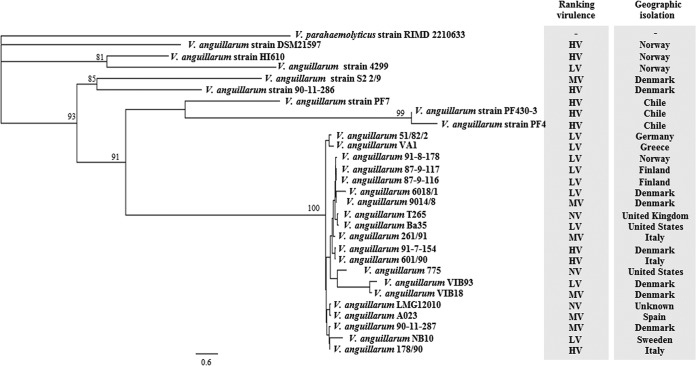
Core genome phylogeny of V. anguillarum strains. The maximum likelihood tree was obtained from a concatenated nucleotide sequence alignment of the orthologous core genes (1,723 genes for both chromosomes) for the 28 V. anguillarum strains. The virulence properties of the strains and geographical places of isolation were added to improve comparison. Bootstrap values of <80% were removed from the tree. The horizontal bar at the base of the figure represents 0.6 substitution per nucleotide site. The virulence ranking of the strains is based on three fish larva models (31). HV, high virulence; LV, low virulence; MV, medium virulence.